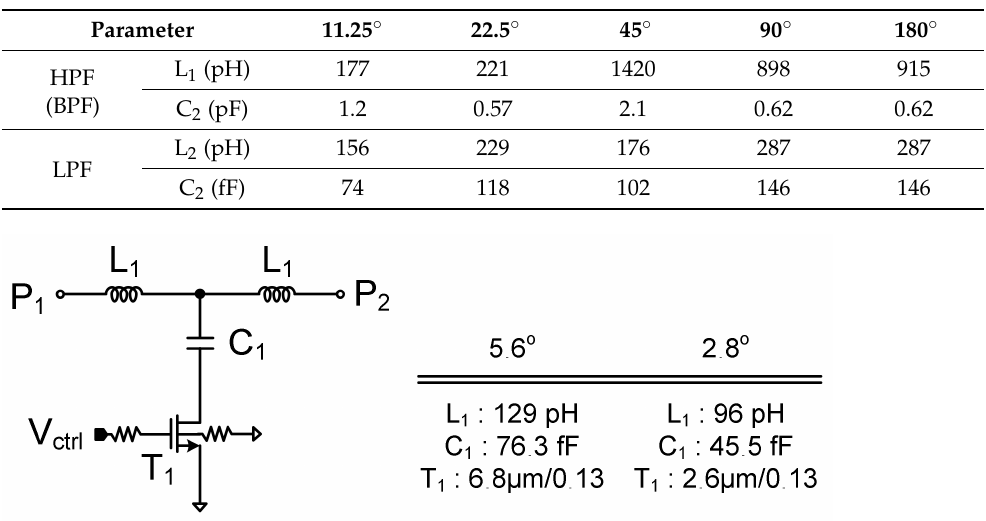
Figure 5. Schematic of the phase shifting elements of 5.6 ◦ and 2.8 ◦